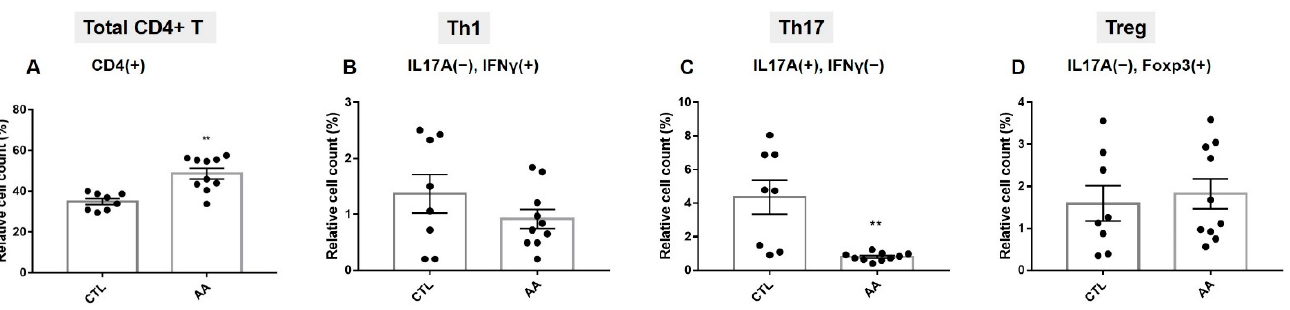
Figure 1. Baseline levels of total CD4+ Th cells, Th1, Th17, and Treg cell subsets in healthy controls ( n = 8) and AA ( n = 10). Relative cell count (%) of ( A ) total CD4+T helper cells, ( B ) IL17A − IFN- γ + (Th1), ( C ) IL17A+IFN- γ − (Th17), and ( D ) IL17A − FoxP3+ (Treg) cells from the control group and AA group. Total CD4+ cells ratio was increased in the AA group compared to the control group. Th17 cell fractions in the AA group were all lower at baseline compared to the control group, although Th1 and Treg cell fraction showed no significant differences. The data represent the means ± SEM, statistically significant at ** p < 0.01 compared to the control.